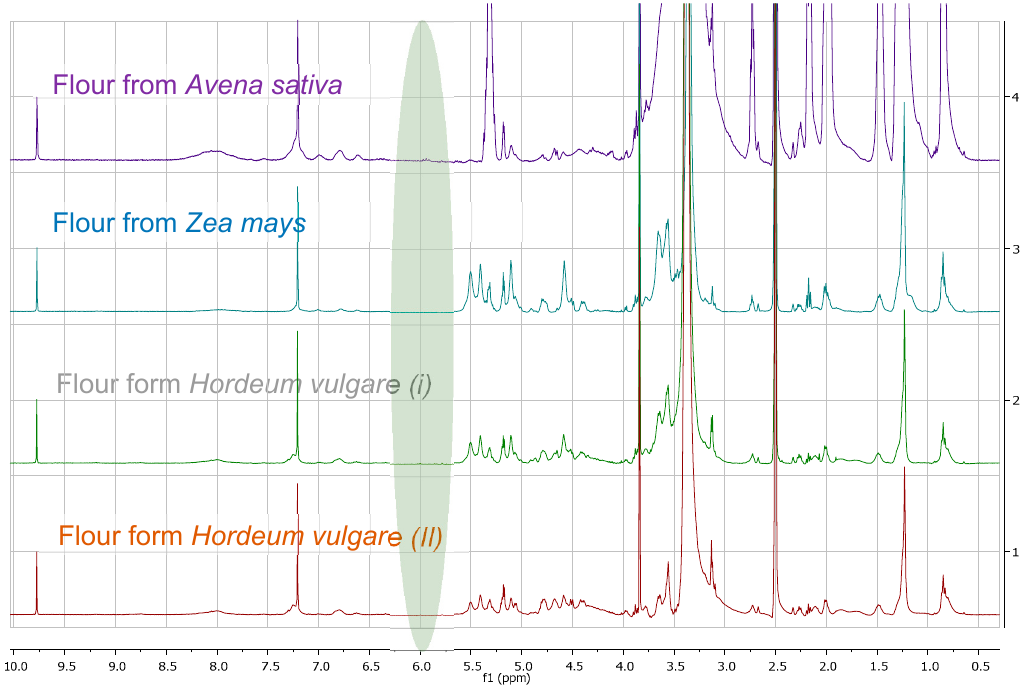
Figure A1. NMR spectra in DMSO from cereal flours without ARS.